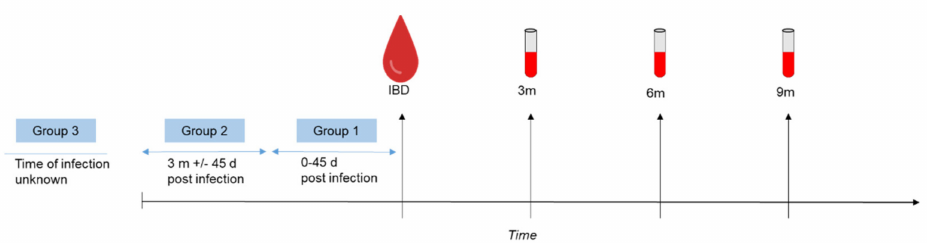
Figure 2. Study workflow and grouping of study participants. Study participants were asked for blood samples 3, 6 and 9 months (3 m, 6 m, 9 m) after the initial blood donation (IBD) that was screened positive for SARS-CoV-2 anti-N total